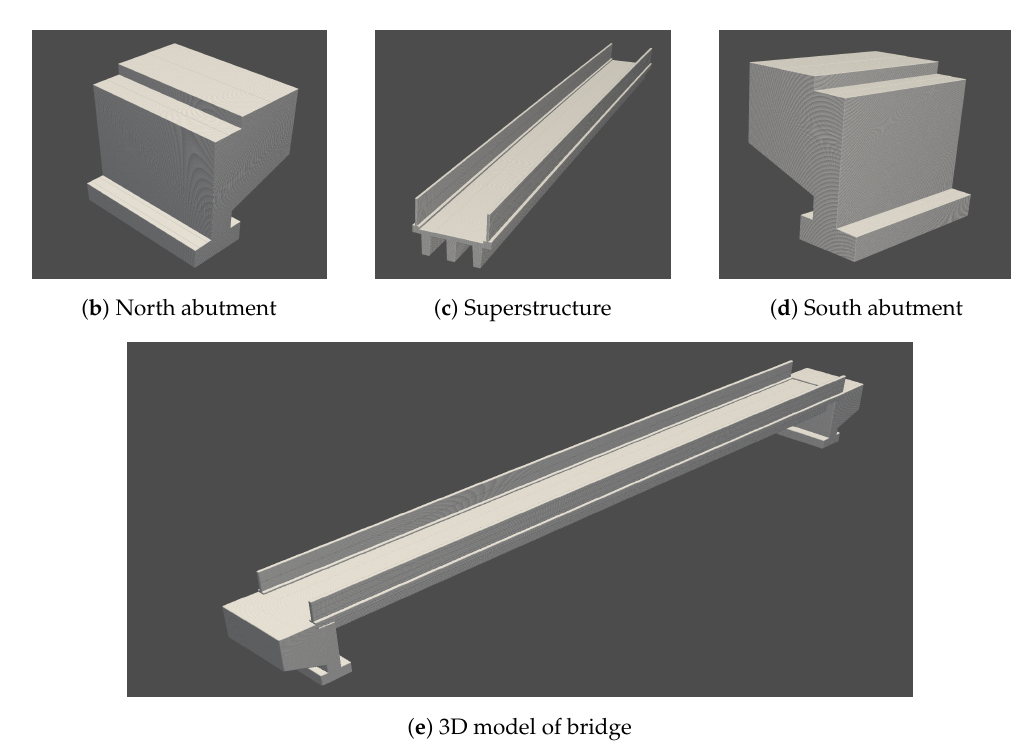
Figure 10. 3D reconstruction of Max-Müller-Steg foot bridge over the Dreisam river in Freiburg. ( a ) is one of the five 2D plans used to reconstruct the parts of the 3D model. ( c ) is a 3D reconstruction of the concrete superstructure of the bridge. ( b , d ) are 3D reconstructions of the north and south abutments of the bridge. ( e ) shows the fused parts of the reconstructed 3D model of the Max-Müller-Steg foot